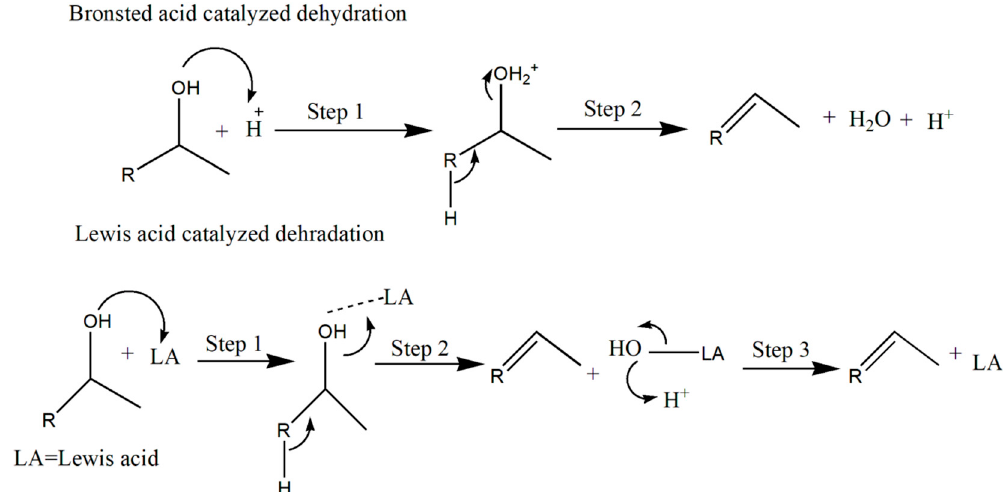
Figure 3. Dehydration mechanism with Bronsted and Lewis acid catalysts [30].